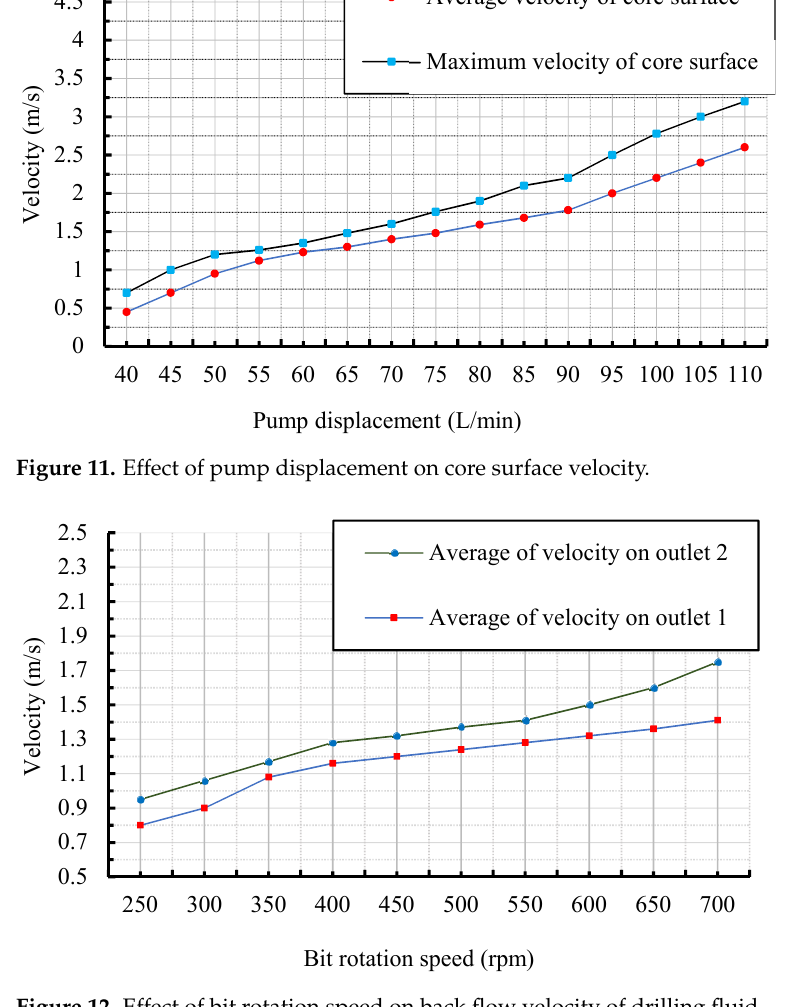
Figure 12. Effect of bit rotation speed on back flow velocity of drilling fluid. Table 3. The regression equation of drilling fluid velocity field on the core surface.